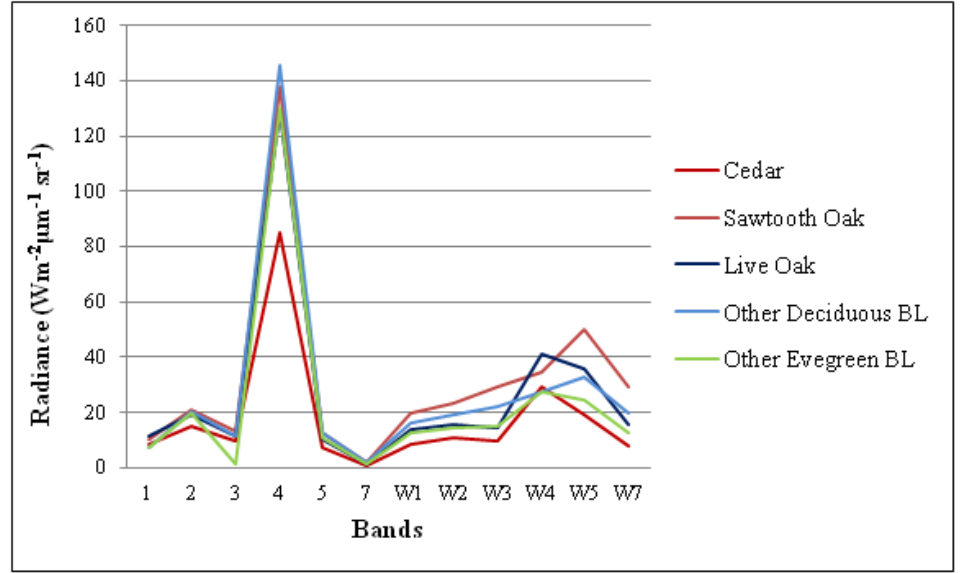
Figure 11. Signatures comparison between the mean radiance values (in Wm −2 ·μm −1 ·sr −1 ) per band for the pixels within the training sites for each forested land cover type. May data mean values for bands 1–5 and 7 are marked by 1–5 and 7, while December data mean values for bands 1–5 and 7 are marked by W1–W5 and